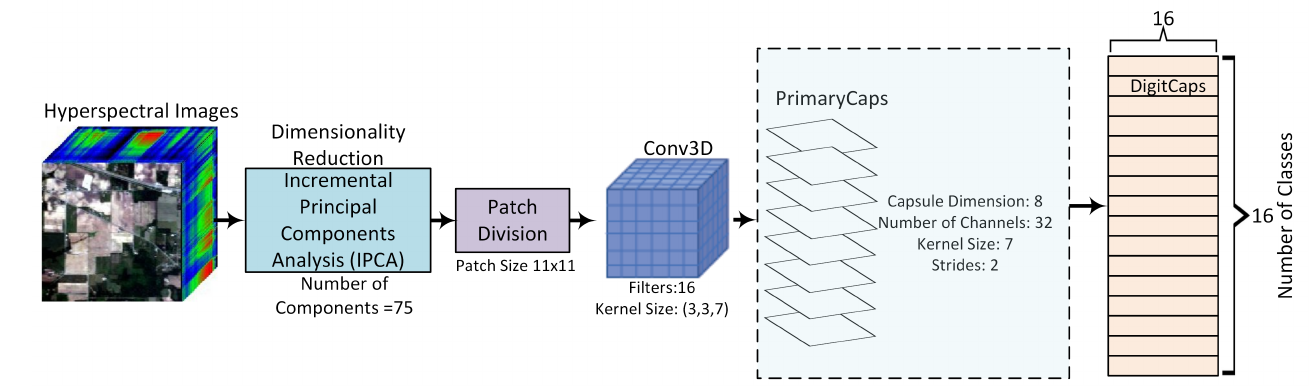
Figure 2. Visual salience based proposed framework for no-reference image quality